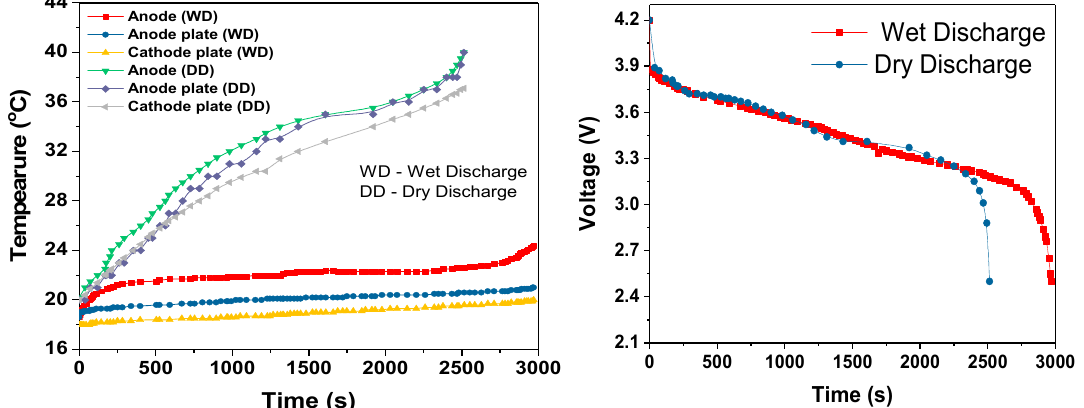
Figure 12. Measured voltage and temperature versus time for the six-cell battery module at the 1C discharge rate, measured at various points in the module.